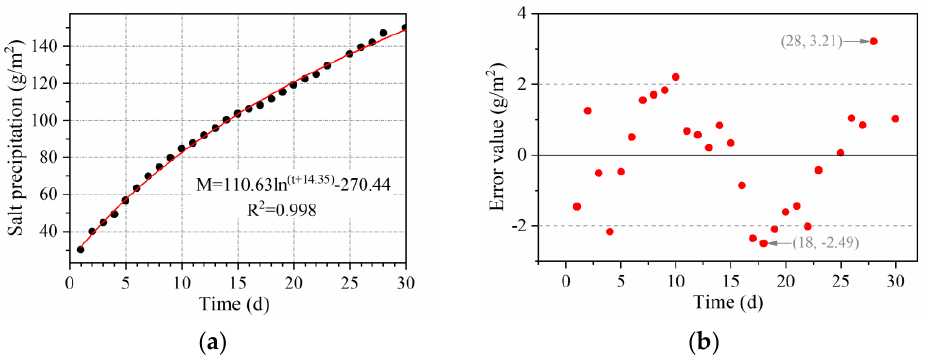
Figure 12. Variation in salt precipitation over time and mathematical fitting error: ( a ) salt precipitation over time; ( b ) error between the predicted value and measured value.